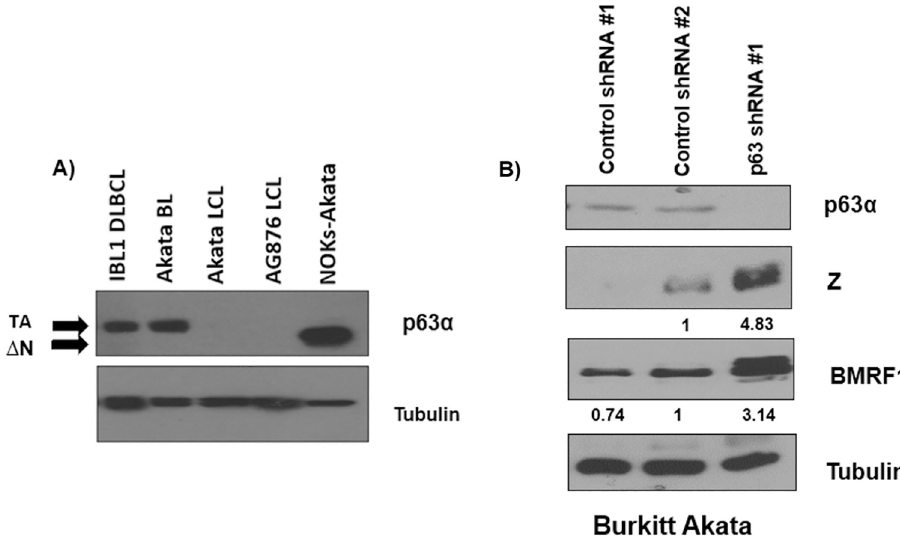
Fig 8. The TAp63 α isoform of p63 inhibits EBV lytic reactivation in Akata Burkitt lymphoma cells. A) The level of TAp63 α isoform expression in various EBV-infected B-cell lines were examined by immunoblot analysis; NOKs-Akata epithelial cells were used as a control for expression of the shorter Δ Np63 α isoform. B) Akata Burkitt lymphoma cells were infected with two different lentiviral vectors expressing control shRNAs or a lentivirus vector expressing shRNA against p63, selected for puromycin resistance, and then assessed by immunoblot analysis for expression levels of the Z, R, BMRF1, TAp63 α and tubulin proteins. The quantification of Z and BMRF1 protein levels was determined through ImageJ, normalized to tubulin, with the control #2 condition set as 1. These experiments are representative of two independent biological replicates.